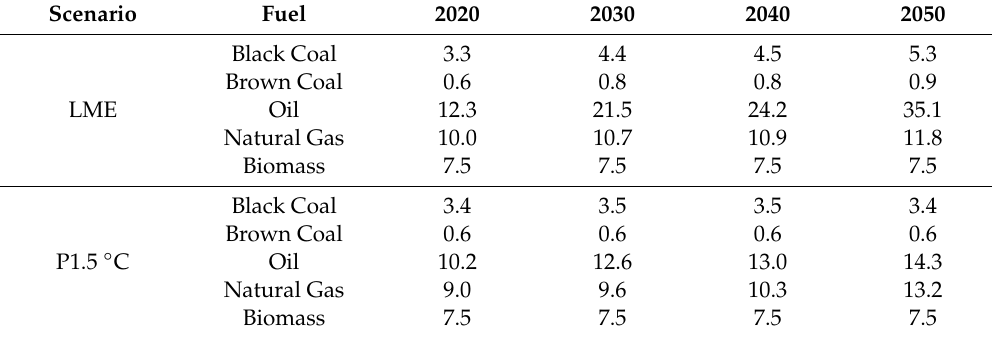
Table A9. Fuel price projections (all costs are in US $2018 / GJ). Data based on Reference [44].